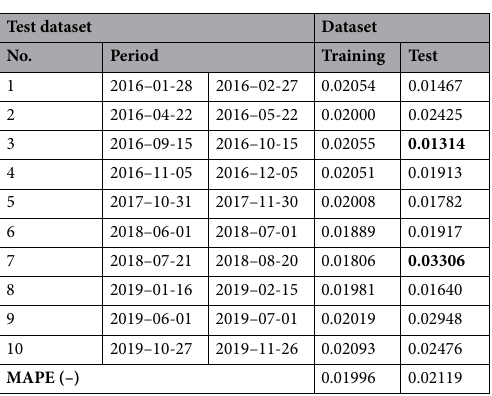
Table 4. Prediction error for a method containing an evolutionary approach. The best and the worst results on the test datasets are emphasised in bold.